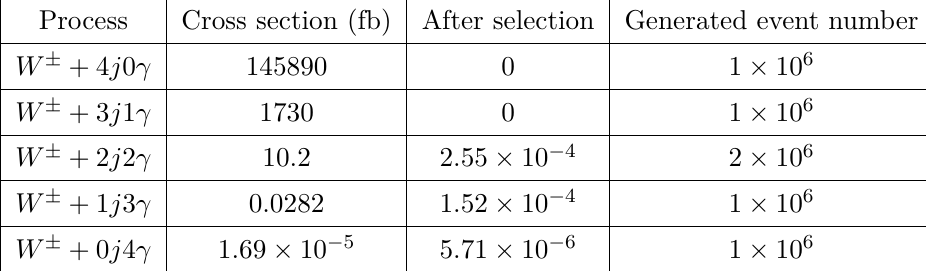
Table 4 . The cross sections of background processes with account cuts and detector